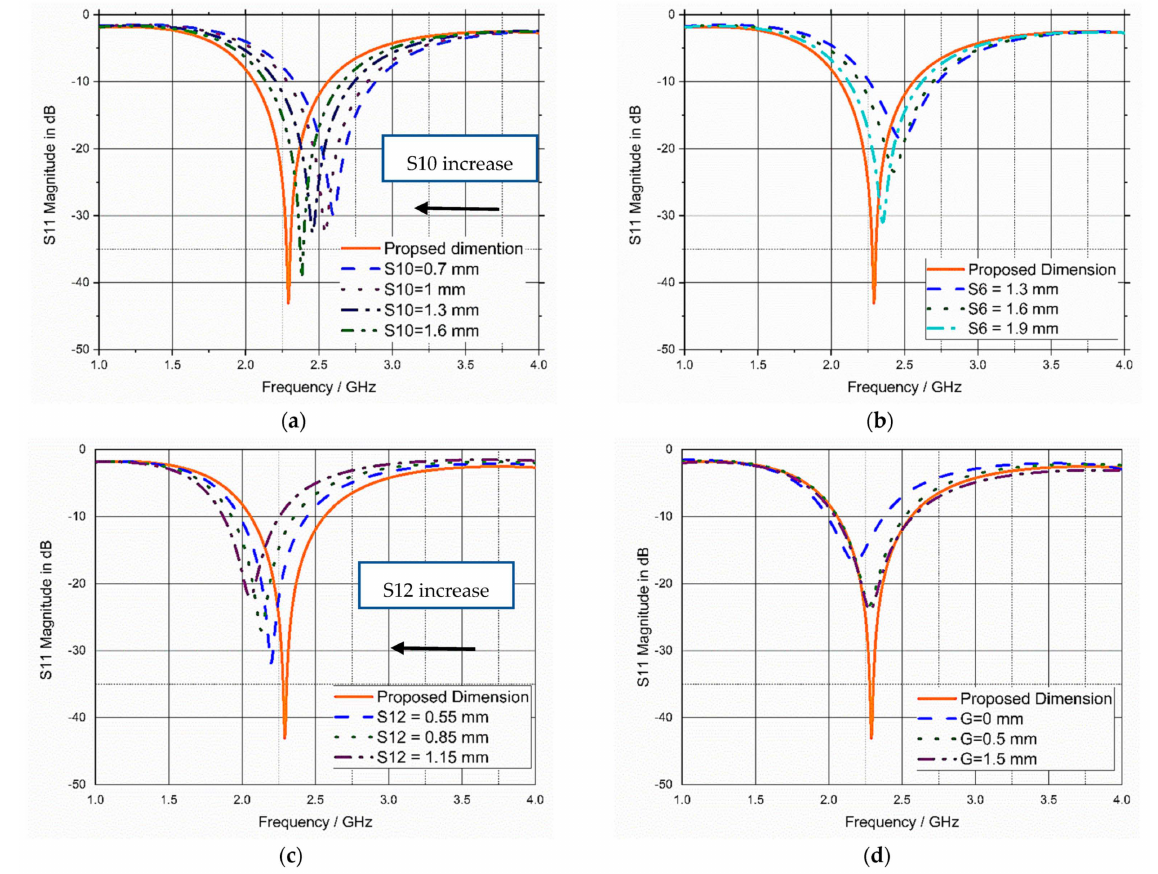
Figure 9. Impact of variation of ( a ) S10, ( b ) S6, ( c ) S12, and ( d ) G (partial ground